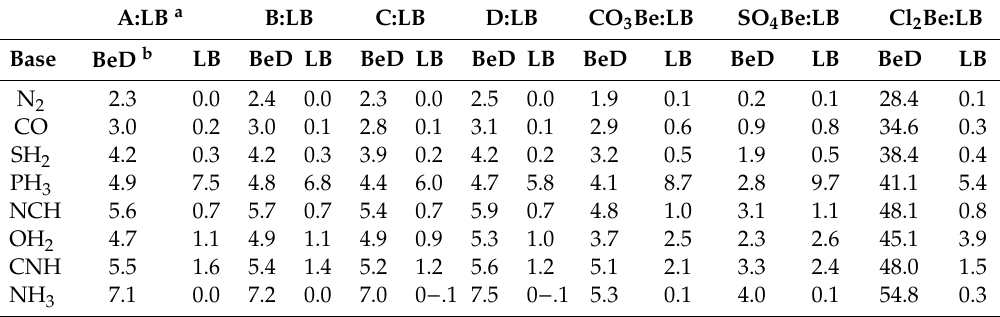
Table 4. Deformation energy (kJ · mol − 1 ) due to the complex formation.